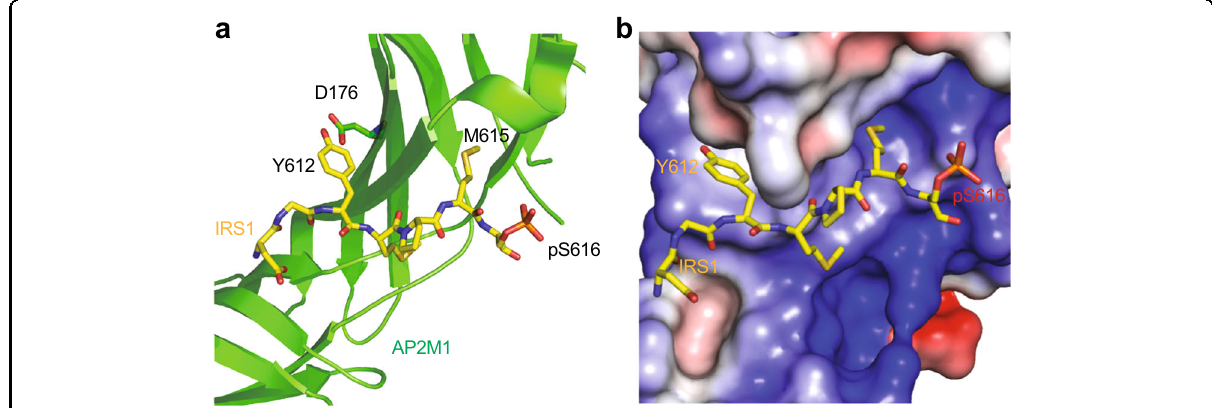
Fig. 2 Structure of AP2M1 bound to pS616-IRS1. a Ribbon diagram of the crystal structure of AP2M1-pS616-IRS1 (PDB ID: 6BNT). b Surface drawing of AP2M1 colored by its electrostatic potential (blue, positive; red, negative; and white, neutral) with pS616-IRS1 shown as